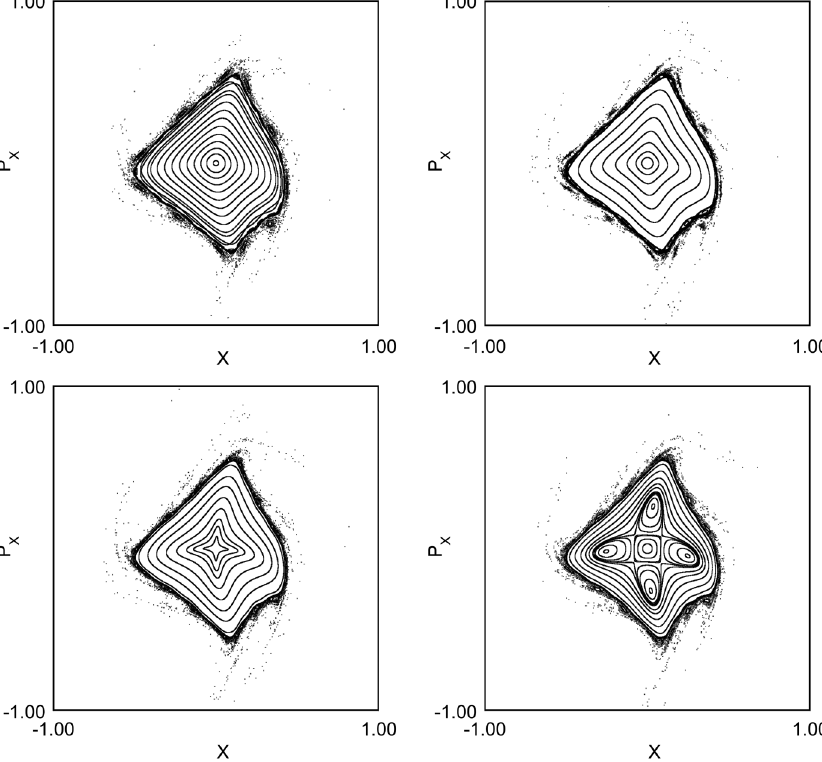
FIG. 9. Phase portrait of the dynamical system [Eq. (3)], corresponding to (cid:2) ¼ 0 : 265 , as the linear tune (cid:2) is changed and approaching the resonant value (cid:2) ¼ 1 = 4 from